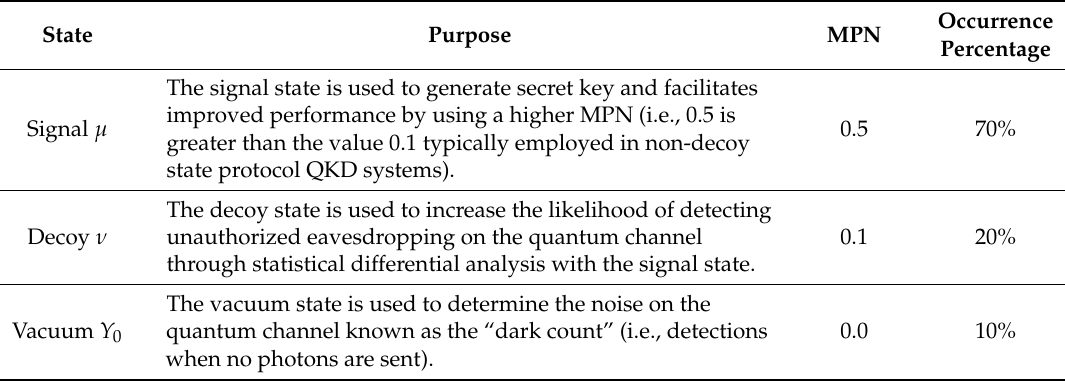
Table 2. Example Decoy State Protocol